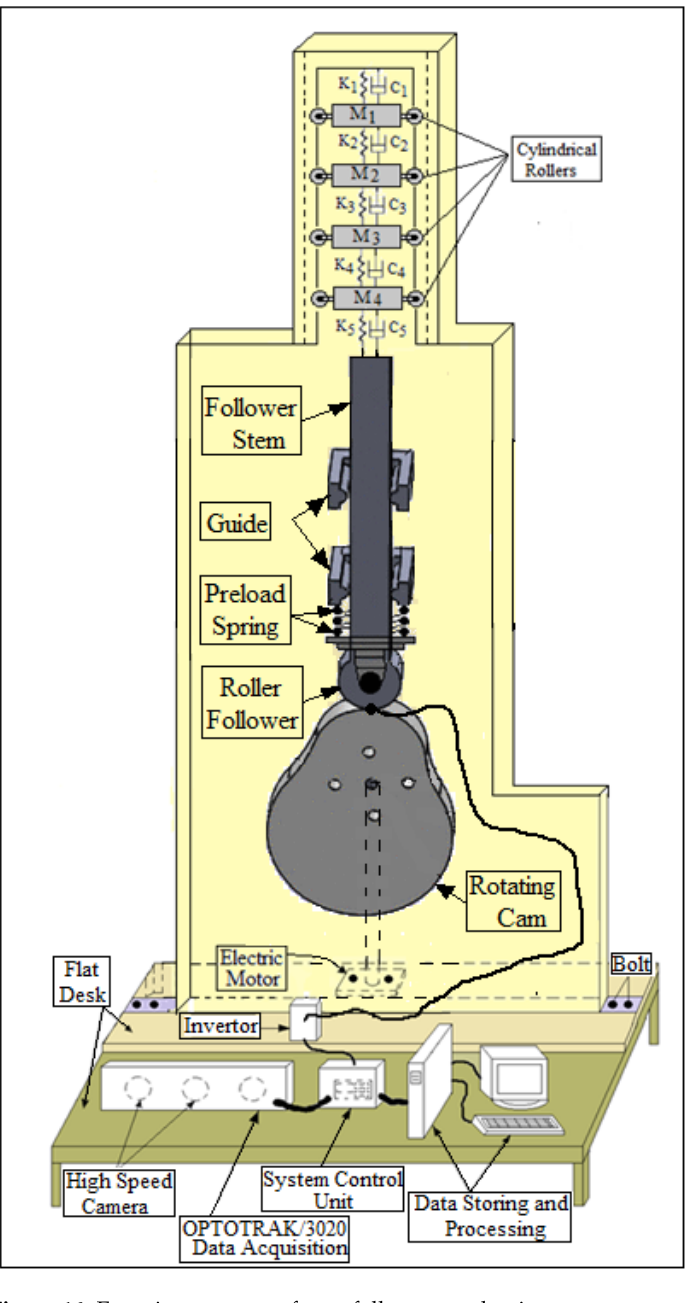
Figure 16. Experiment setup of cam-follower mechanism.